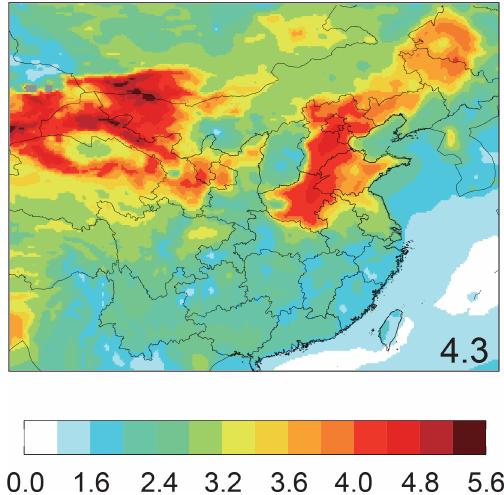
Figure 4. Model-simulated mean aerosol pH values at the surface in China from 17 October 2014 to 20 January 2015 from Run_Het. Number in inset represents the mean calculated pH values in Bei-